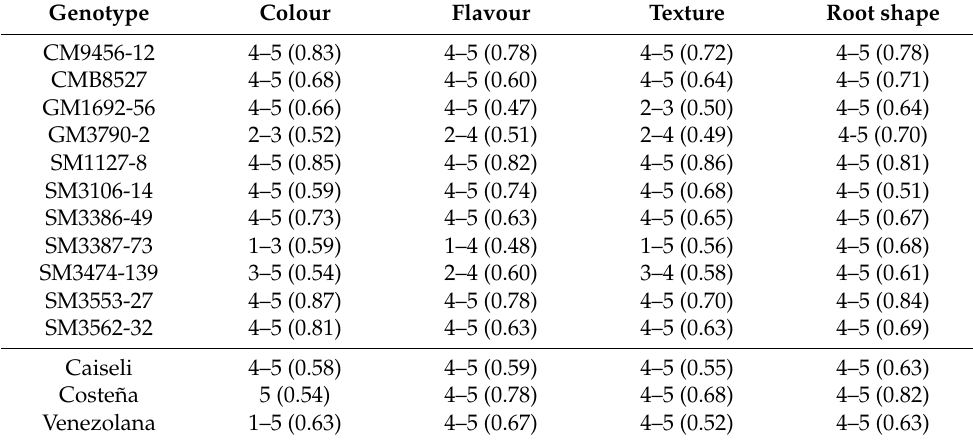
Table 9. Liking categories for the evaluated cassava genotypes.